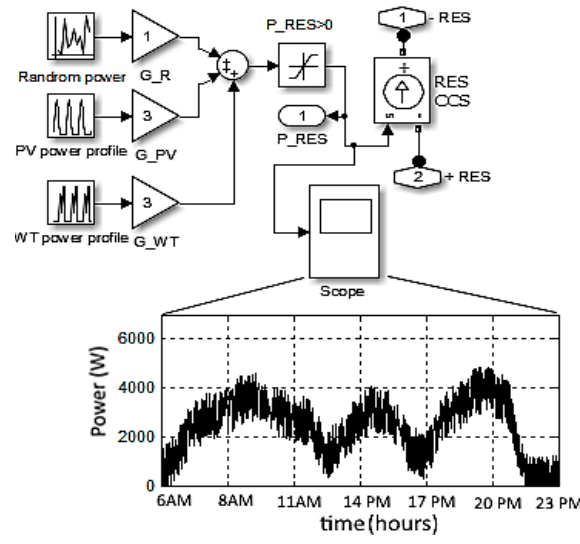
Figure 3. The diagram of the RES model.